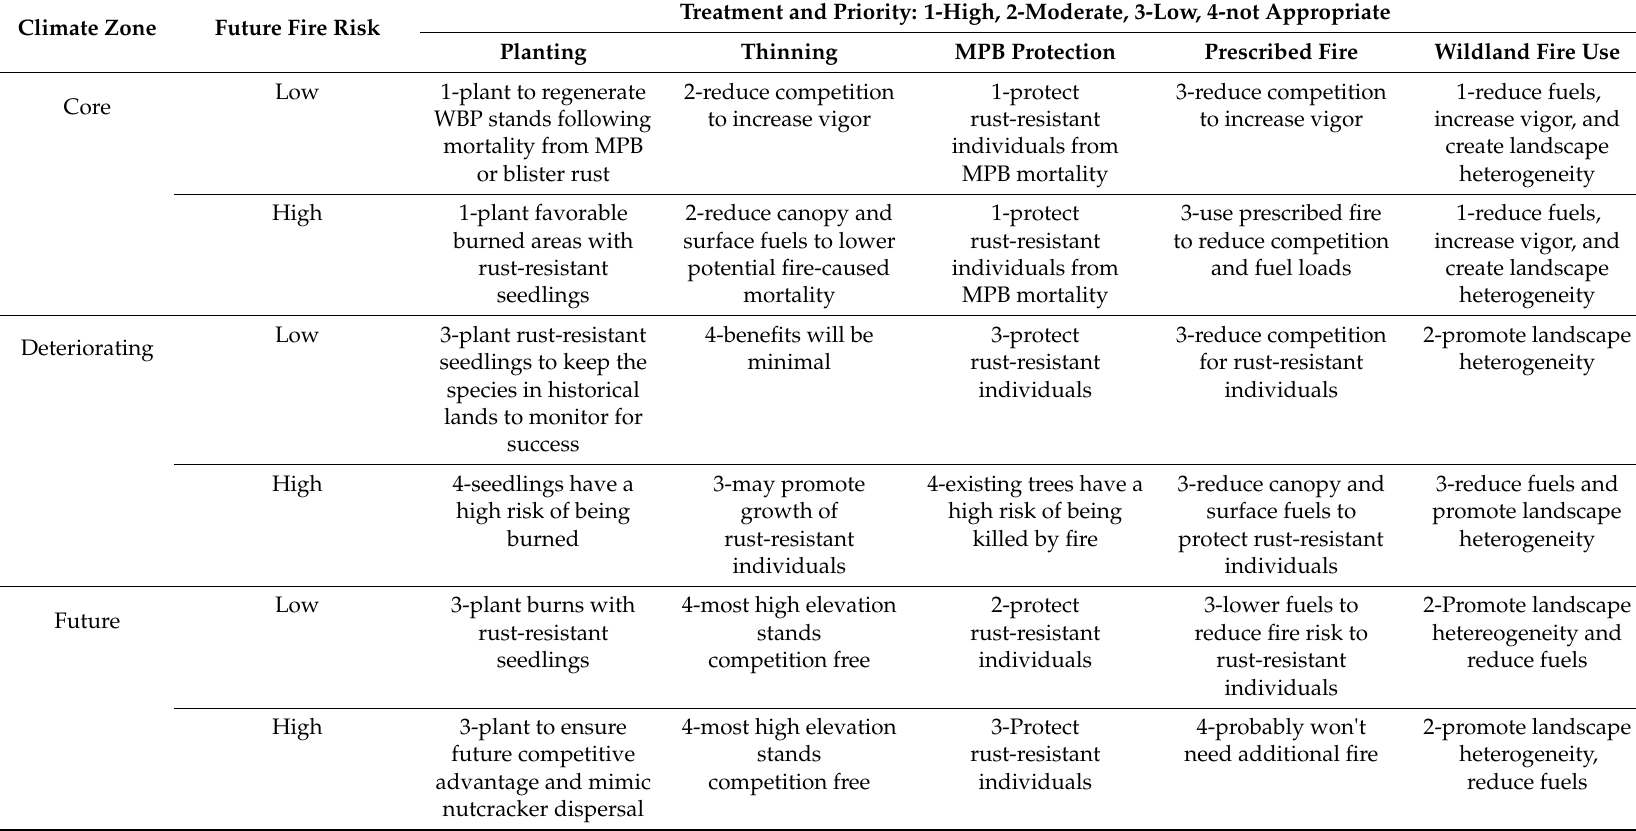
Table 5. An example of placing treatments in the landscape based on future climate suitability for WBP and future fire risk. MPB refers to mountain pine